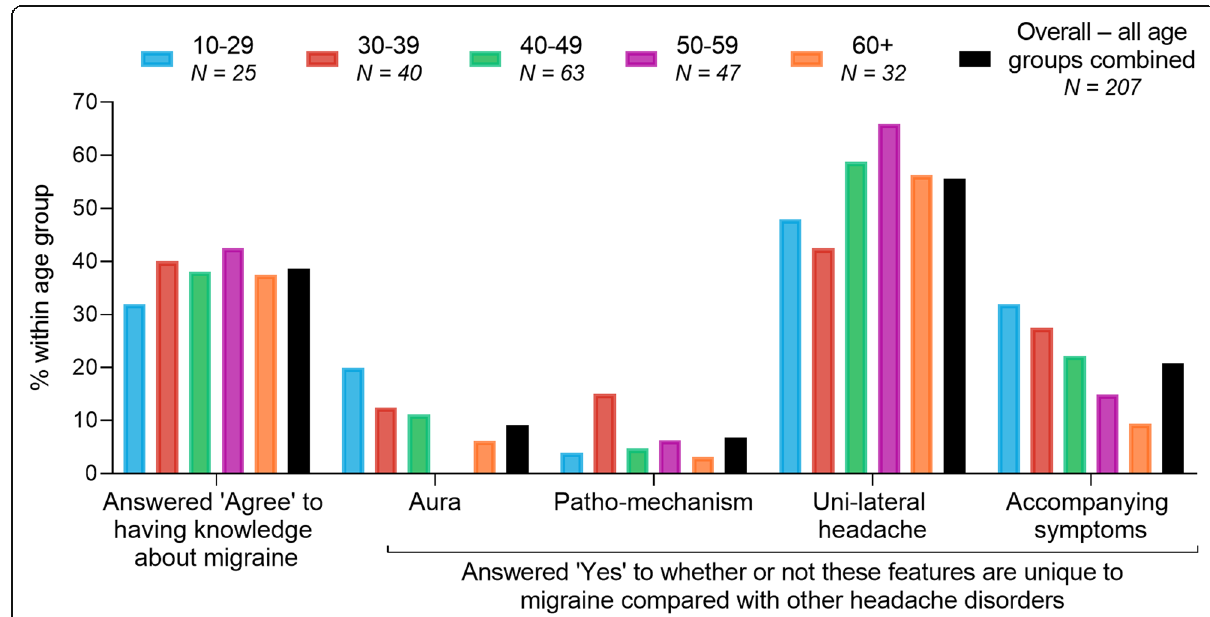
Fig. 1 Knowledge about migraine. Results for knowledge of migraine are presented for each age group and for overall respondents, the latter inclusive of all age groups. Results are presented as percentage of respondents. N = Number of